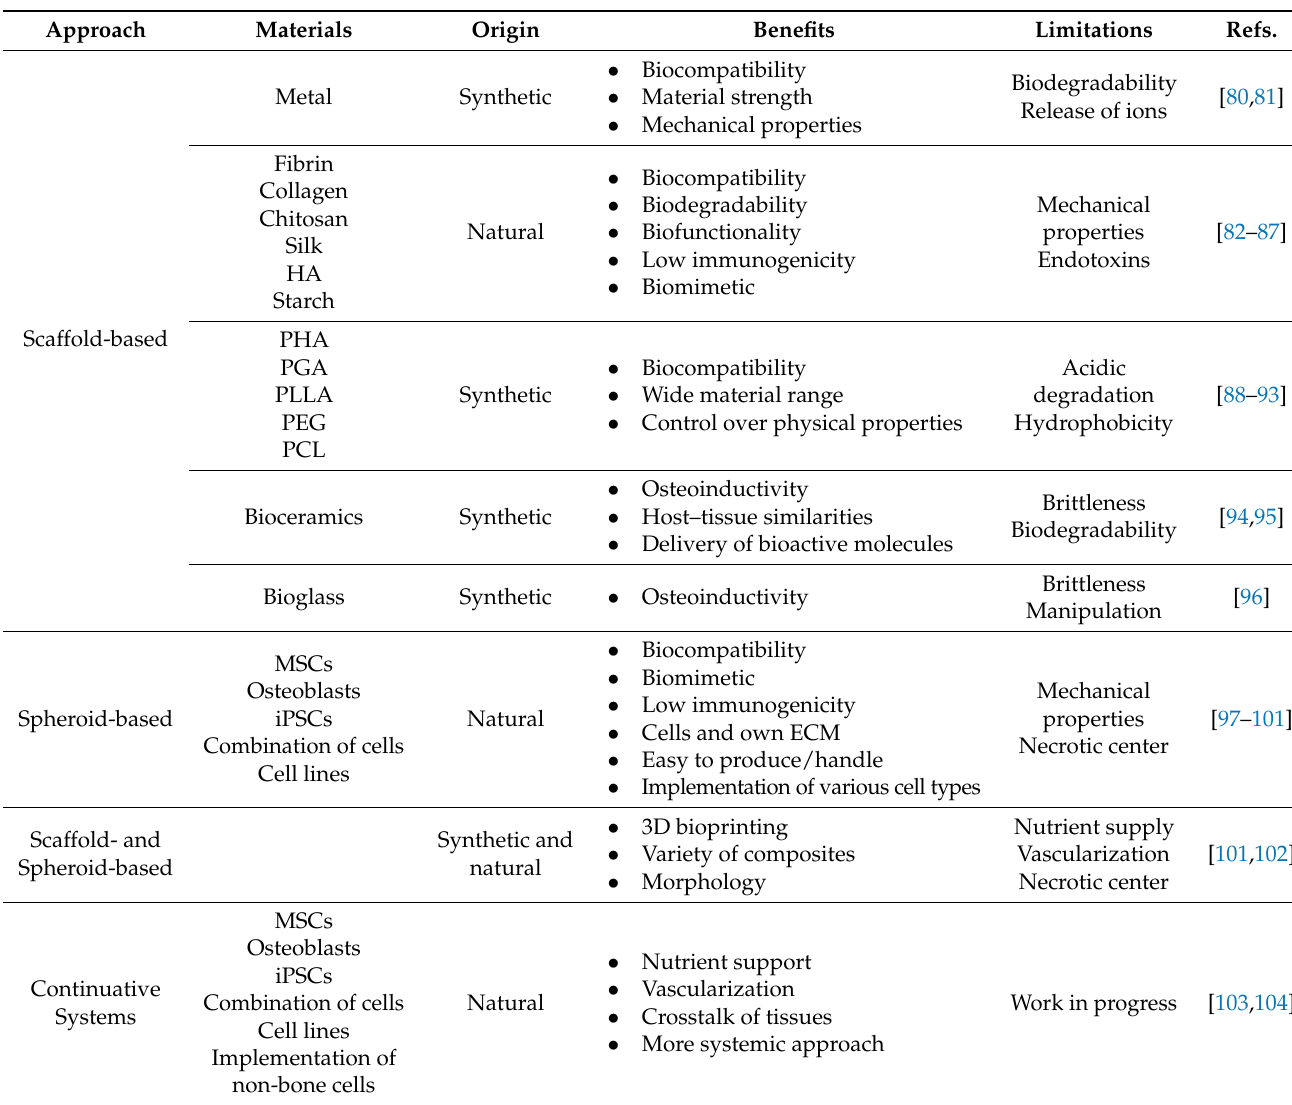
Table 2. Overview of various BTE